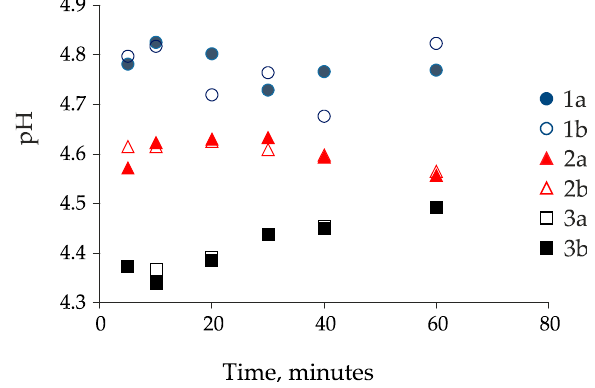
Figure 3. The dependence of the pH of the suspension on the time of the experiment. 1, 2, 3 = Na-, HAl 13 - and Al 13 -bentonite, respectively. Empty and filled icons (a,b) = repetitions of the experiment.